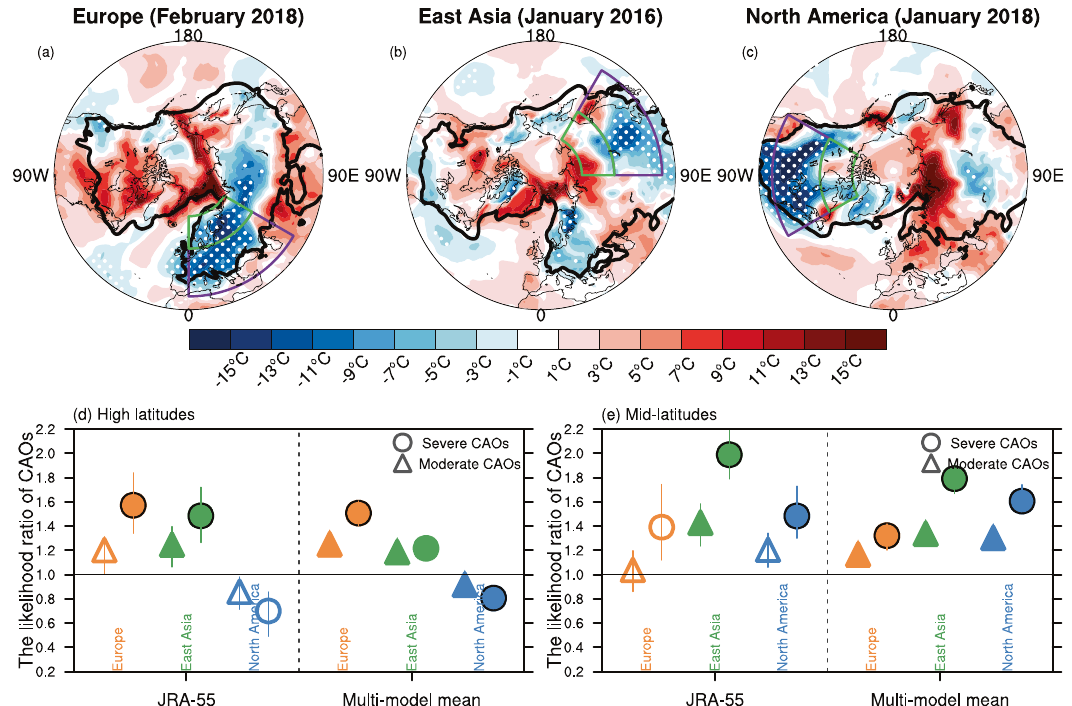
Fig. 1 Three widely reported CAOs in recent years and the risk of CAOs. a – c Anomaly of surface air temperature on 27 February 2018, 22 January 2016, and 1 January 2018 when a severe CAO occurred in Europe, East Asia, and North America, respectively. According to previous studies 61,62 , the occurrences of European CAO and East Asian CAO are in fl uenced by the polar vortex weakening. Stippled regions indicate that the anomalies are − 1.2 times lower than the local standard deviation of SAT anomaly and show which regions could be de fi ned as severe in this study. Green (purple) boxes represent the high- latitude (mid-latitude) regions in this study. The thick black solid contours indicate zero isotherms. d The simultaneous likelihood ratio of severe CAOs (circle) and moderate CAOs (triangle) over high-latitude Europe (in orange), East Asia (in green), and North America (in blue) under weak polar vortex conditions for the reanalysis dataset (left column) and the multi-model mean (right column). e As shown in ( d ), but for the likelihood ratio in mid-latitudes. The fi lled markers denote that the likelihood is statistically signi fi cant and the circles with a black outline indicate that the differences between the risk of severe and moderate CAOs are statistically signi fi cant with a 95% con fi dence level based on 1000-time bootstrap samples with replacement. The error bars denote 95% con fi dence intervals estimated by 1000-time bootstrap samples with